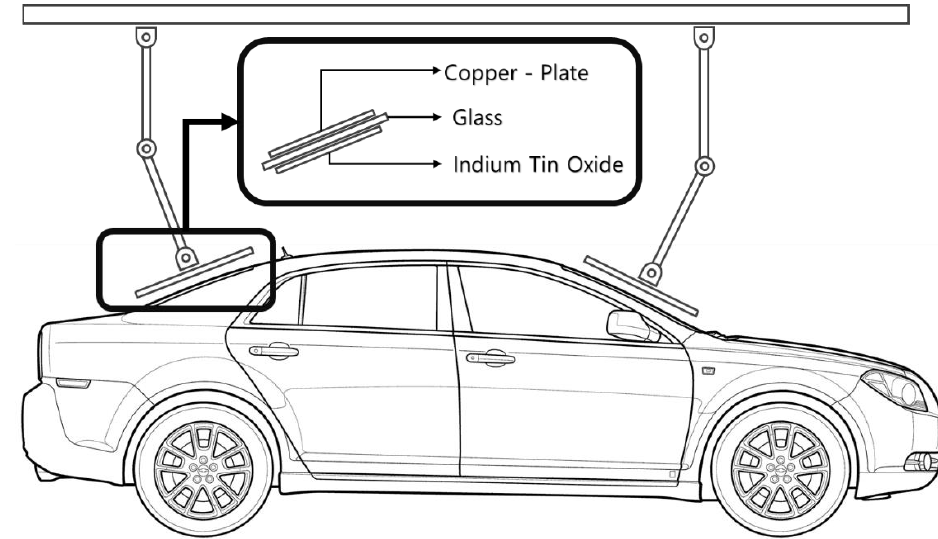
Figure 3. Proposed capacitive coupling wireless power transfer (CCWPT) charging system using the windows of an electric vehicle.